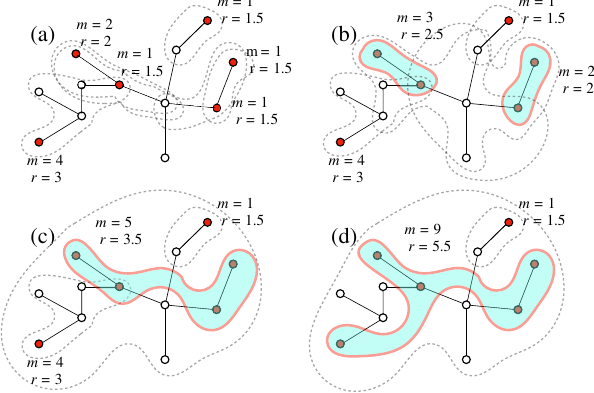
FIG. 1. Schematic illustration of the CMP process for r ð m Þ ¼ 1 þ m= 2 . Filled nodes are active; empty nodes are inactive. Areas bordered by dashed lines are interaction domains of active nodes or clusters. Clusters are indicated by solid lines surrounding a filled area. Notice in (c) and (d) the isolated active node on the upper right corner, which is within the interaction range of the large cluster but cannot be merged as it has r < 2